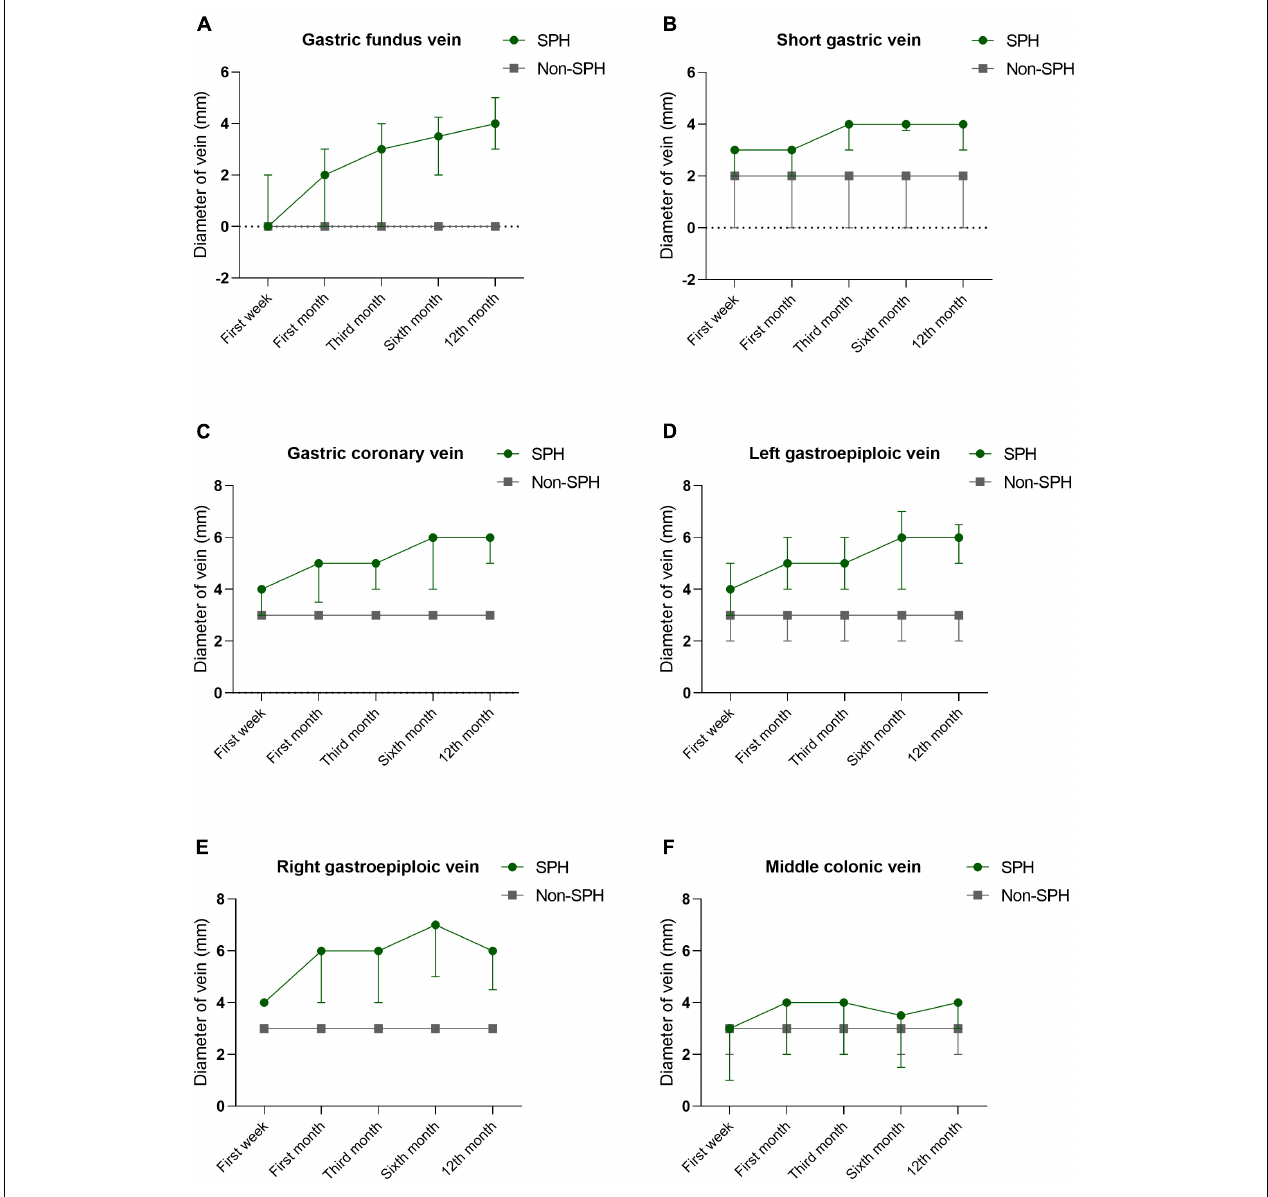
FIGURE 2 | The Dynamic changes of maximum diameters in varicosed veins during the first week, first month, third month, sixth month, and 12th month of follow-up. Most common gastric varices analyzed include gastric fundus vein (A) , short gastric vein (B) , gastric coronary vein (C) , left gastroepiploic vein (D) , right gastroepiploic vein (E) , and middle colonic vein (F) , and it shows an increasing trend in the diameter for these varices, which did not recover within 1